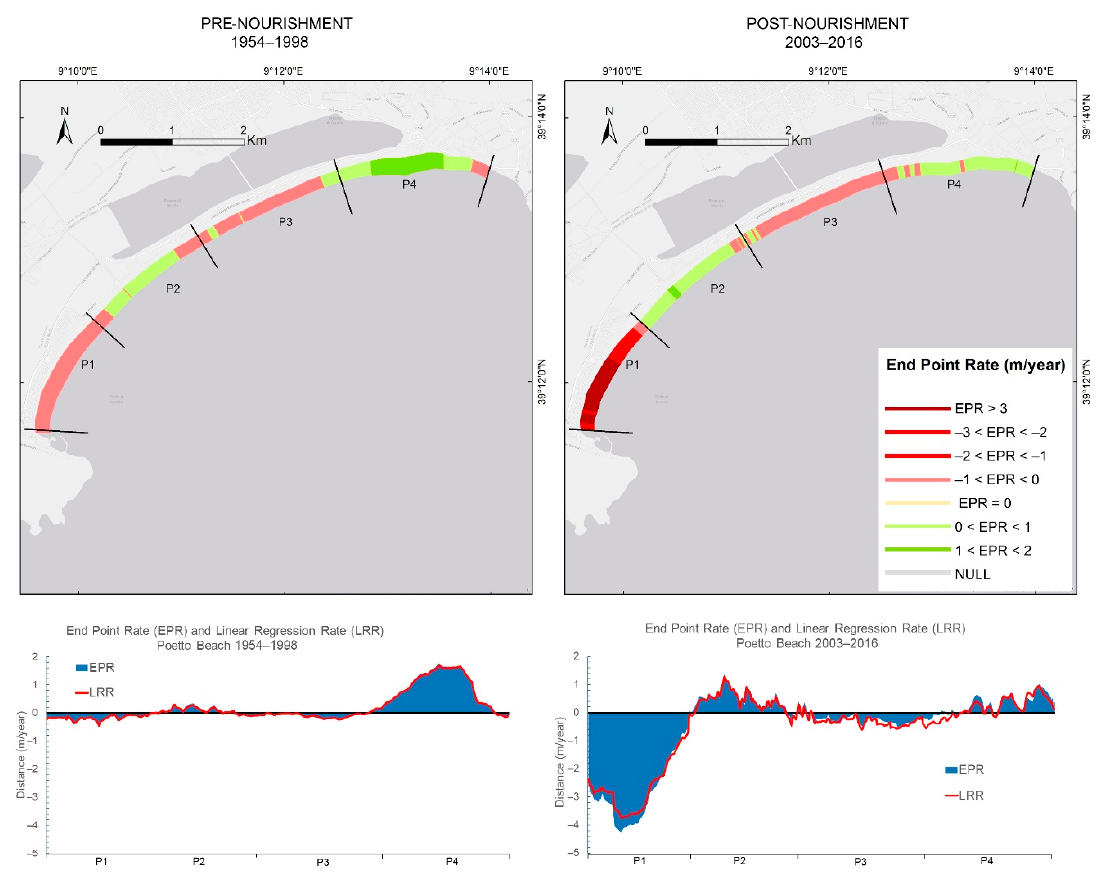
Figure 6. Maps (above) showing the rates of shoreline movement, expressed as end point rates (EPRs) and linear regression rates (LRRs), along the Poetto beach for pre-nourishment (1954–1998) ( left ) and post-nourishment (2003–2016) ( right ) years, superimposed with the limits of the four discriminated sectors (P1–P4); EPR and LRR trends (below) plotted against distance (west to east), with the x-axis showing the limits of the P1 − P4 sectors. Positive values of indicate areas of accretion, whilst negative values indicate areas of shoreline retreat.